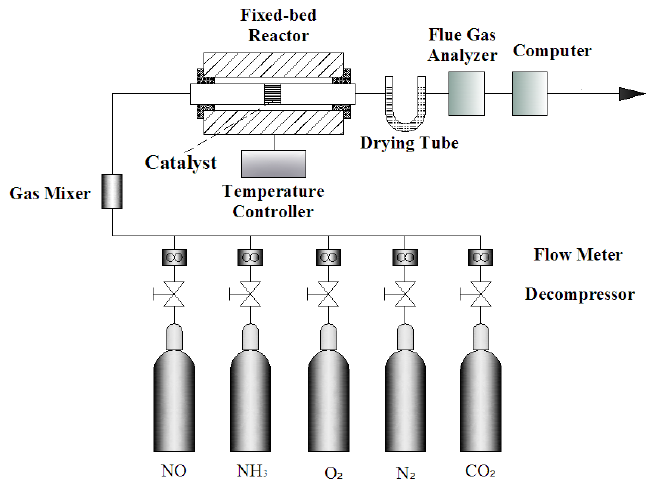
Figure 1. Schematic diagram of the selective catalytic reduction of NO x with NH 3 (NH 3 -SCR) reaction system.